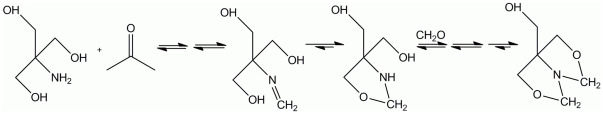
Quenching of formaldehyde cross-linking by Tris.The Schiff-base intermediate, formed from Tris's primary amine and formaldehyde, is attacked by the neighboring hydroxyl group to form a highly favored 5-membered ring. This sequence of reactions is repeated to form a second ring and produce the stable end product, 1-aza-3,7-dioxabicyclo[3.3.0]octane-5-methanol.